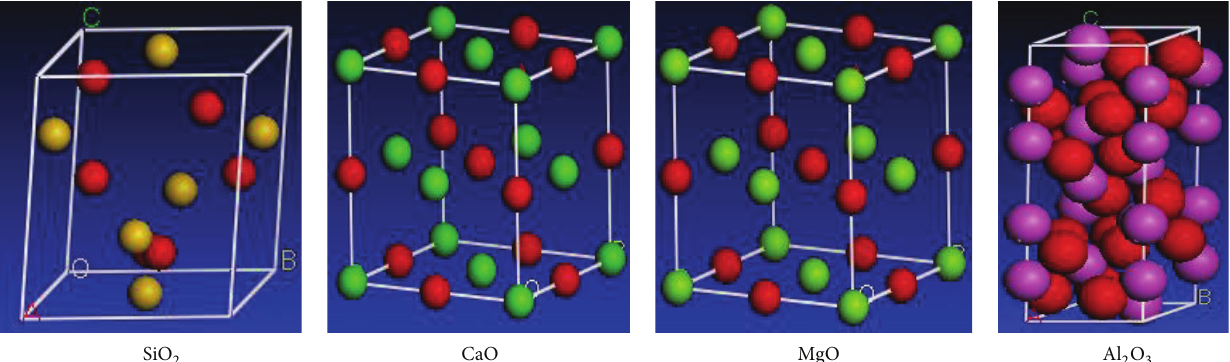
Figure 5: Four kinds of oxide molecular cell